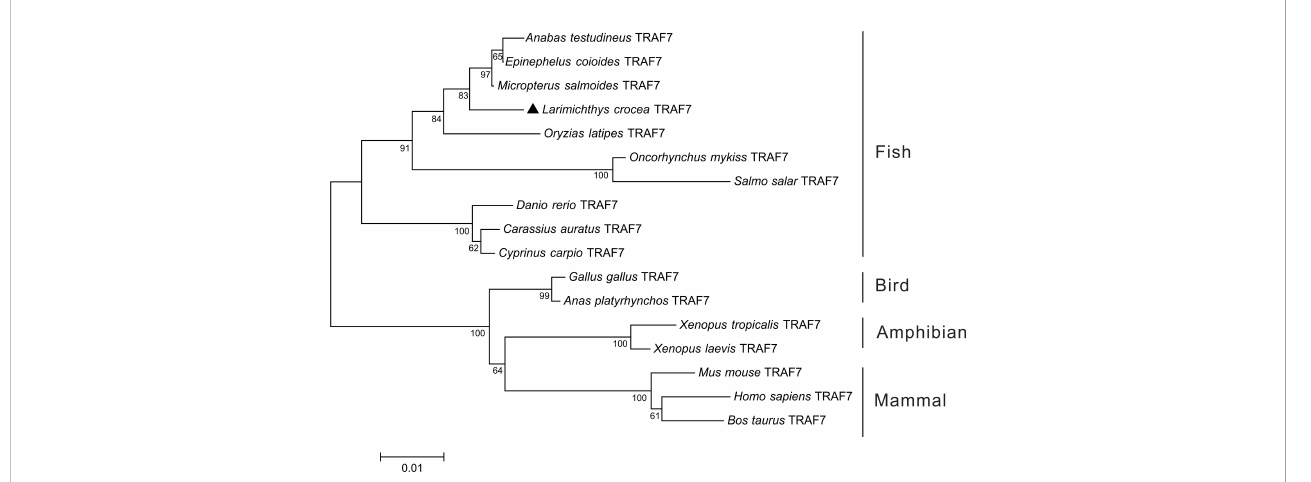
FIGURE 1 Phylogenetic analysis of vertebrate TRAF7 orthologs. The phylogenetic tree was constructed based on the alignment of amino acid sequences of Lc - TRAF7 with other vertebrate TRAF7 orthologs using the neighbor-joining method of MEGA 7.0 software with 10,000 replications of the bootstrap test. Lc -TRAF7 is marked with a triangle, and the numbers on the branch represent the bootstrap values. The GenBank association numbers for TRAF7 orthologs used are as follows: L. crocea , ON357640; E. coioides , AME21335.1; Anabas testudineus , XP_026211477.1; Micropterus salmoides , XP_038548977.1; O. latipes , XP_004071899.1; Oncorhynchus mykiss , XP_036829477.1; Salmo salar , XP_045571926.1; D. rerio , NP_001073654.1; Cyprinus carpio , XP_042578745.1; C. auratus , XP_026064477.1; Anas platyrhynchos , XP_027324633.1; G. gallus , NP_001012546.2; Xenopus tropicalis ,